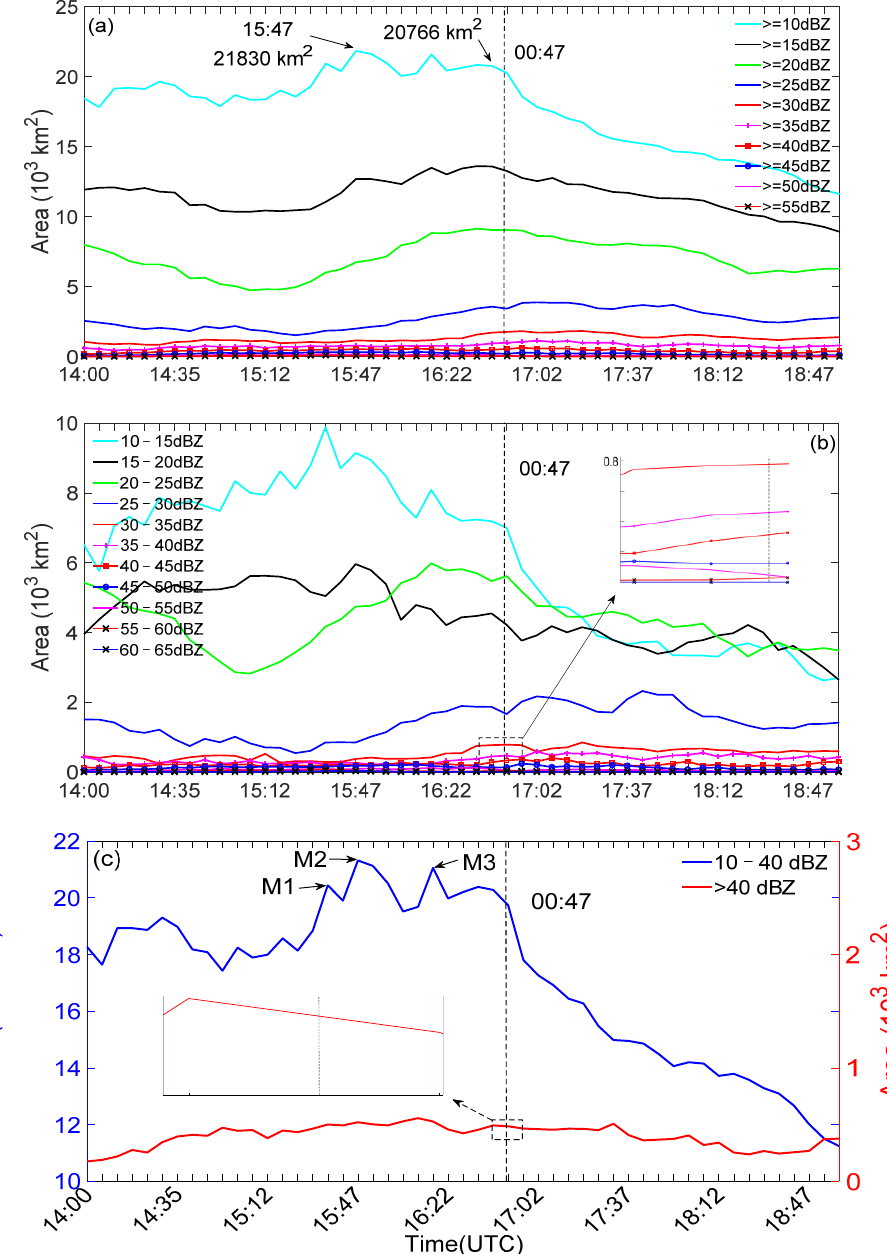
Figure 7. The evolution of different radar reflectivity areas of the sprite-producing thunderstorm. ( a ) The evolution of radar reflectivity larger than a certain value. ( b ) the evolution of different radar reflectivity. ( c ) the evolution of radar reflectivity with 10–40 dBZ (blue line) and larger than 40 dBZ (red line). The dashed line in the figure shows the occurrence time of the sprite.